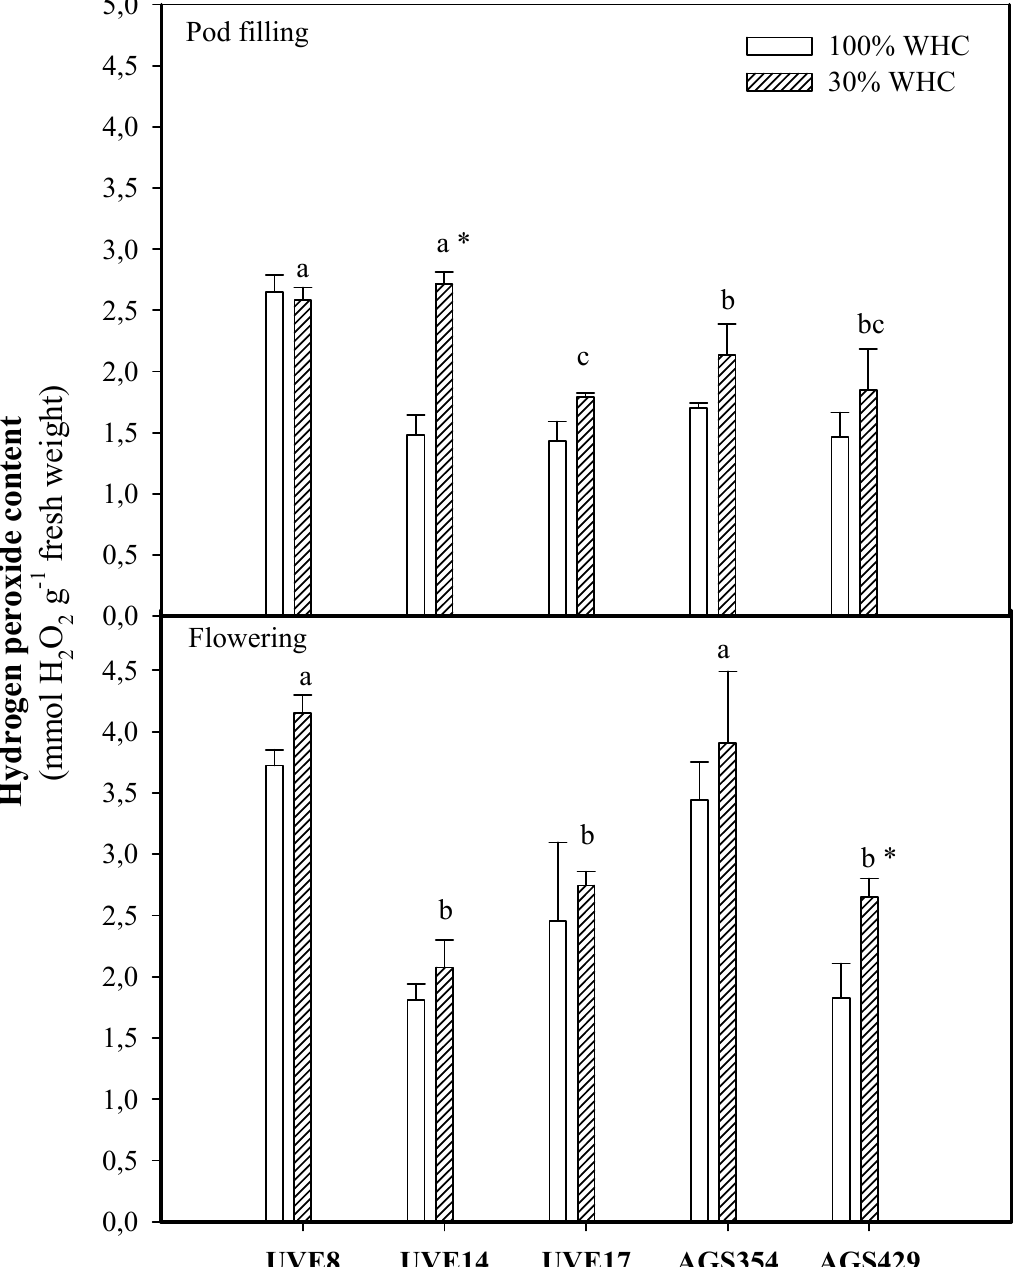
Figure 4. Hydrogen peroxide contents for five vegetable-type soybean cultivars subjected to two water treatments at flowering and pod-filling stages. Values represent means ± SD ( n = 3). Letters represent significant differences/similarities in H 2 O 2 content for various cultivars under severe water stress at 30% water holding capacity (WHC), * represents significance at p ≤ 0.05.